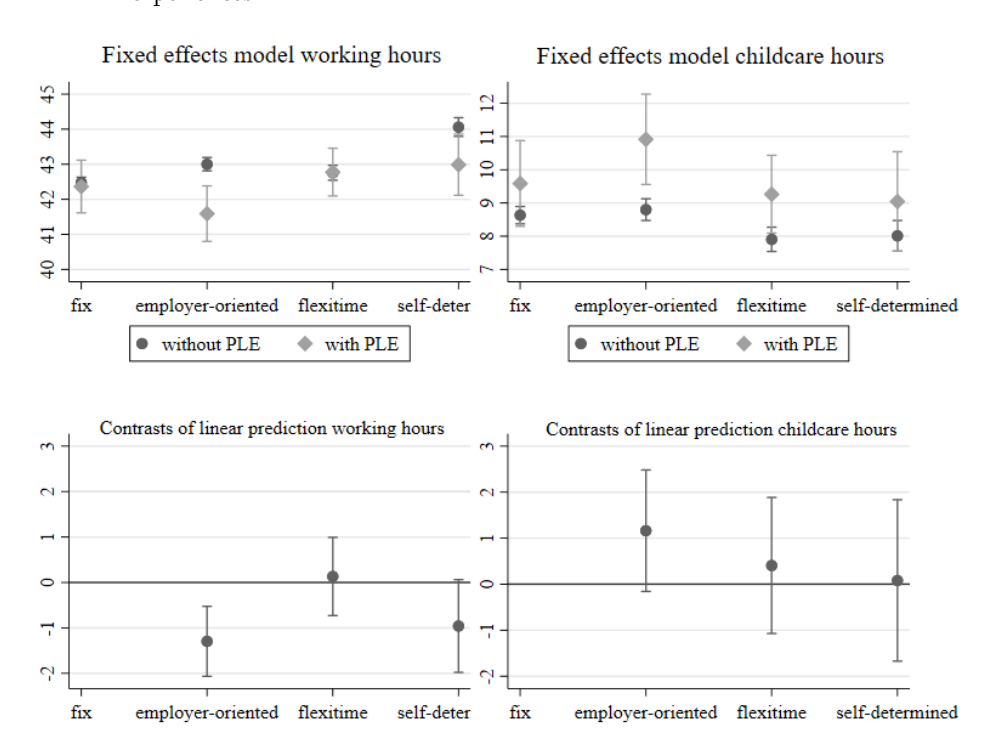
Figure 3 : Linear prediction and contrasts of working and childcare hours for fathers with interaction between working time arrangements and parental leave